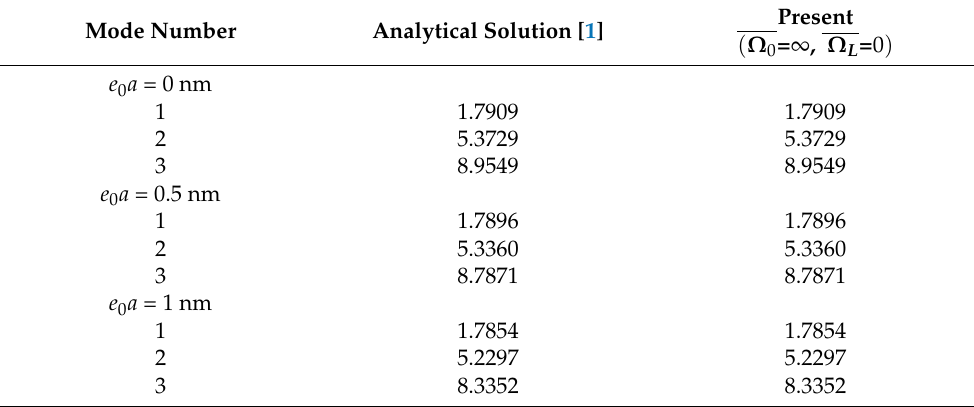
Table 2. Comparison of the first three non-dimensional axial frequencies of randomly oriented short-fiber-reinforced composite nano-rods for the clamped–free boundary